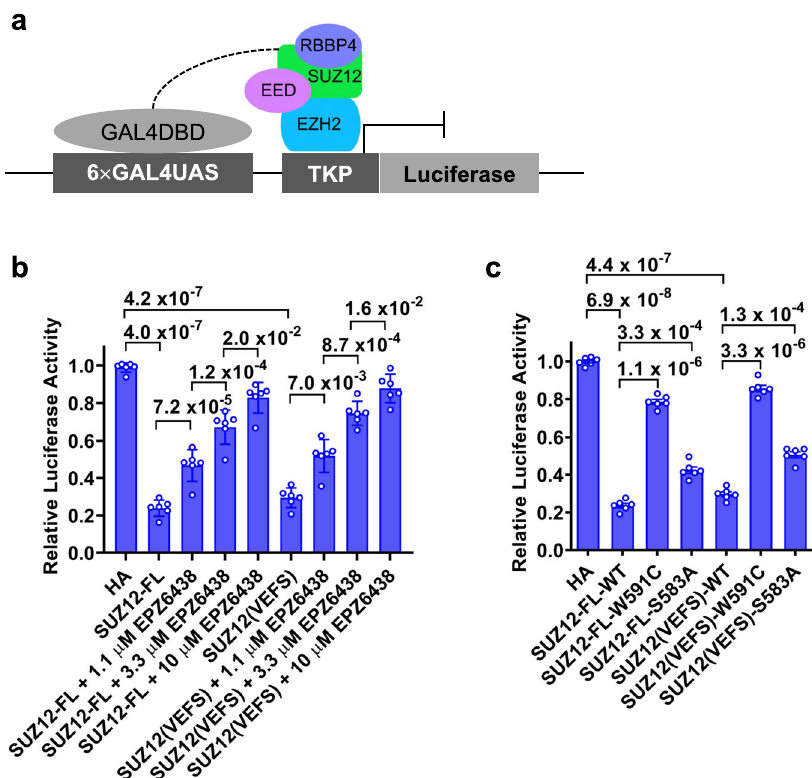
Fig. 5 | S583 phosphorylation facilitates reporter gene repression. a Schematic of GAL4-based reporter gene repression assay. b PRC2 enzymatic activity- dependent reporter gene repression. GAL4DBD-HA-tagged SUZ12-FL or SUZ12(- VEFS) was transiently expressed in HEK293T cells that lack endogenous SUZ12. EPZ6438isaselectiveenzymeinhibitorofPRC2.In b and c ,assayswereperformed onthreedifferentdayswiththemeasurementof tworeplicatewellsrecorded each time. Signals were normalized to. GAL4DBD-HA negative control. p values were